Question: Briefly state, in one sentence, what is plotted here.
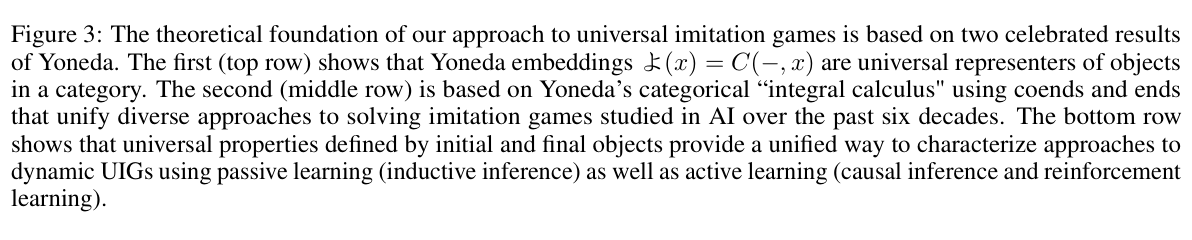
Answer: depicts a classification of universal imitation games (UIGs) that will be the primary focus of our paper. In Turing’s original model, discussed above, the participants were assumed to be static, that is, they were not adapting during the course of the interactions. In the case that participants are static, we can try to distinguish between them using a large variety of methods, ranging from distance-based methods like kernel methods Schölkopf and Smola (2002) or optimal transport Villani (2003), or density-based methods such as constructing a generative model. The fundamental ideas developed by Yoneda, in particular Yoneda embeddings よ(x) = C(−, x) and (co)ends play a major role in our paper. For example, Avery (2016) showed that the set of probability distributions on a set can be defined as a